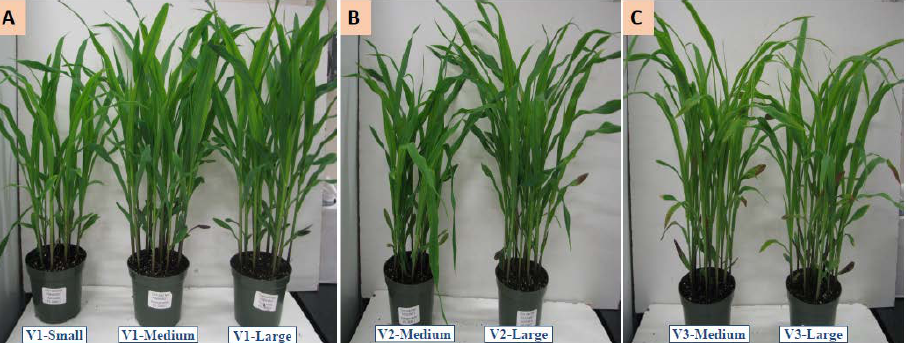
Figure 1. Four-week-old hybrid corn seedlings. ( A ) Variety 1 (from left to right: small, medium, and large); ( B ), Variety 2 (from left to right: medium and large); ( C ), Variety 3 (from left to right: medium and large).